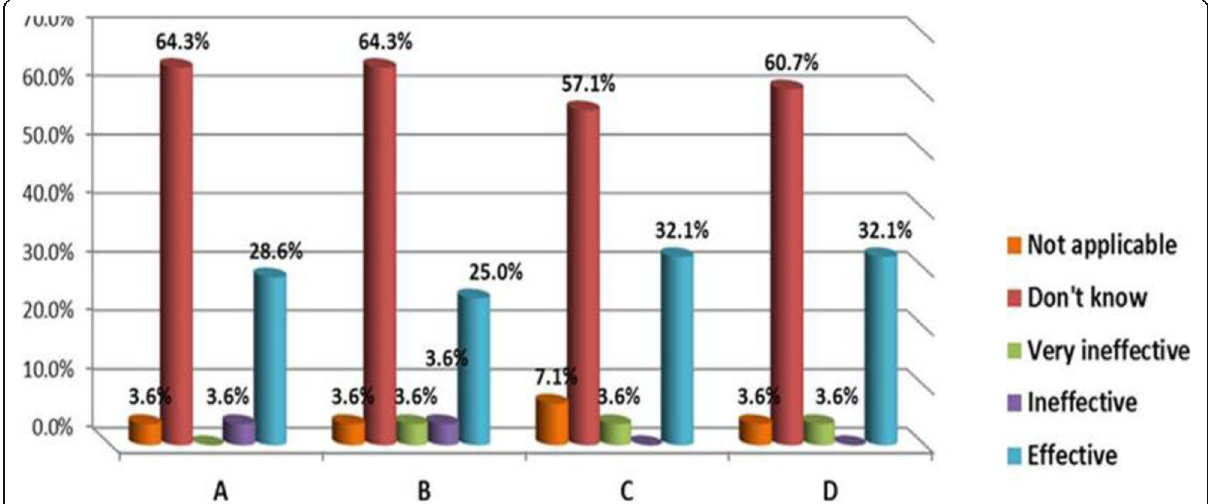
Fig. 3 Pre-education knowledge of the respondents ’ physicians and pharmacists about the role of antimicrobial stewardship. a . Improving patient outcomes. b . Improving patient safety (Minimize unintended consequences of antimicrobials). c . Reducing resistance. d . Reduce healthcare costs (without adversely impacting quality of